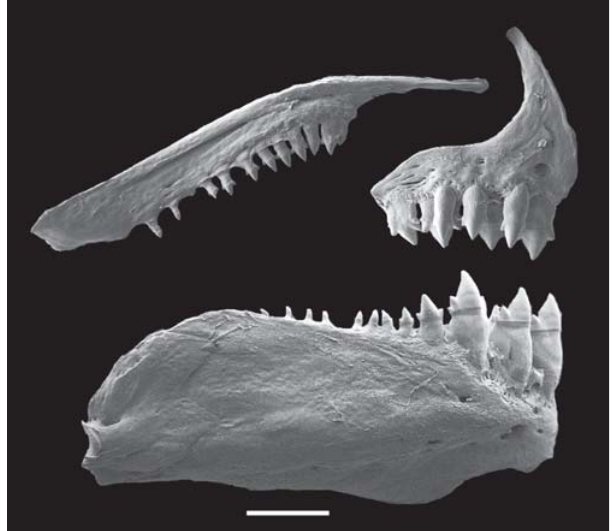
Fig. 6. Hemibrycon helleri , ANSP 180775, female, 66.6 mm SL. Scanning electron micrograph of right side upper and lower jaws. Scale bar = 1